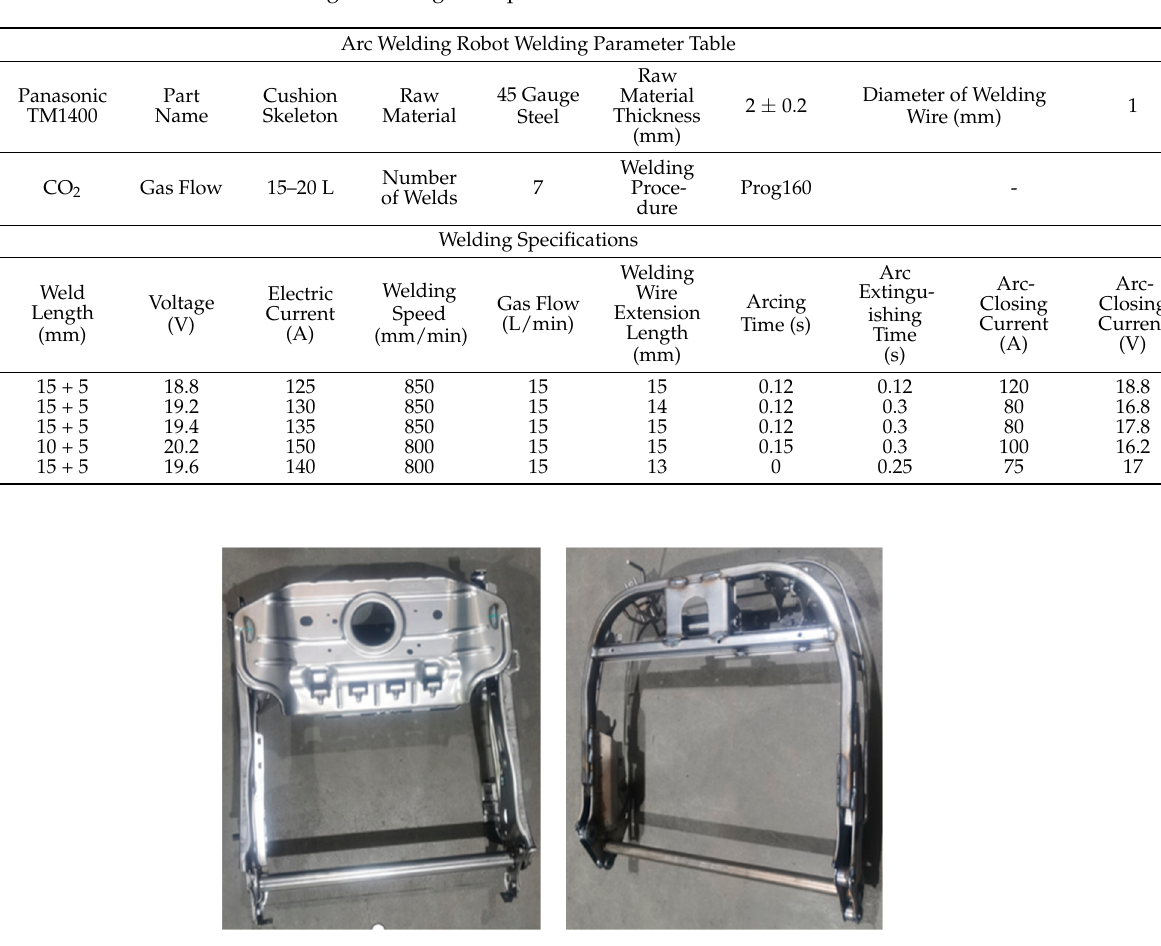
Figure 3. Welding parts.